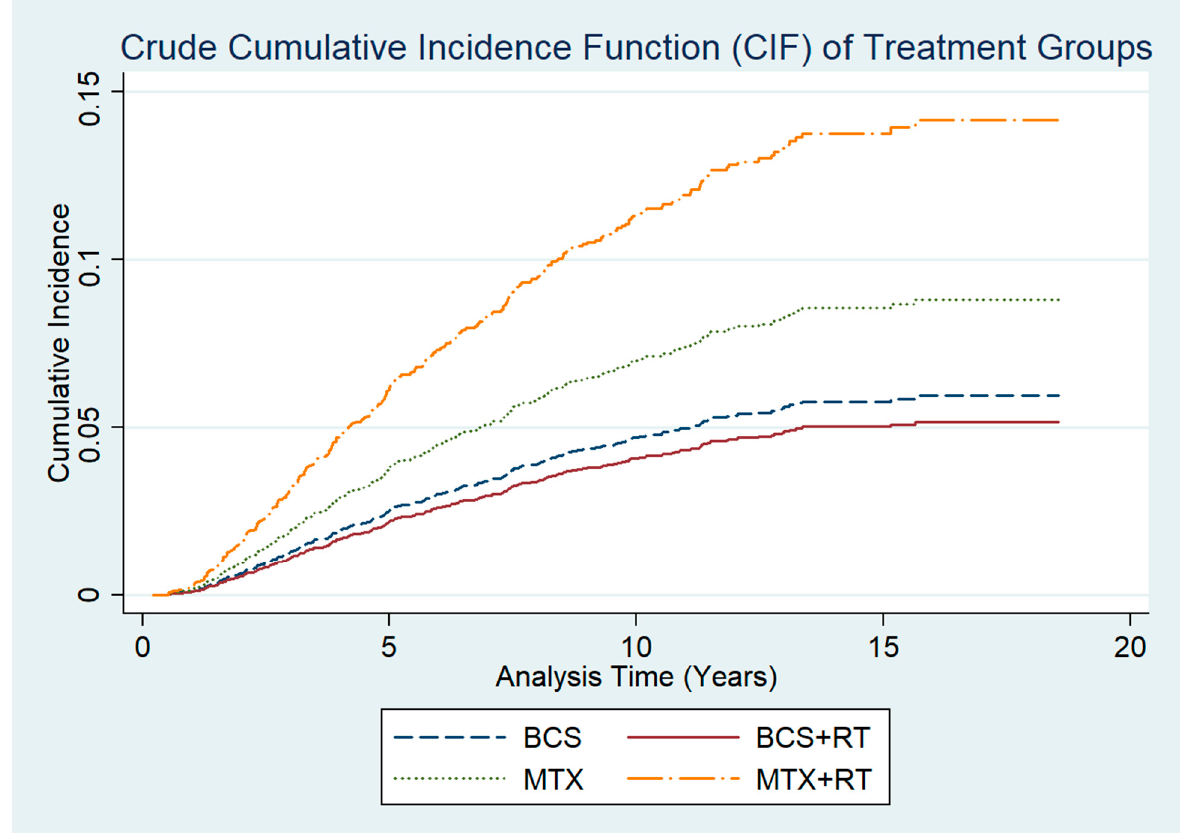
Figure 2. Crude cumulative incidence function (CIF) plot of breast cancer-specific mortality across BCS, BCS + RT, MTX and MTX + RT surgical treatment